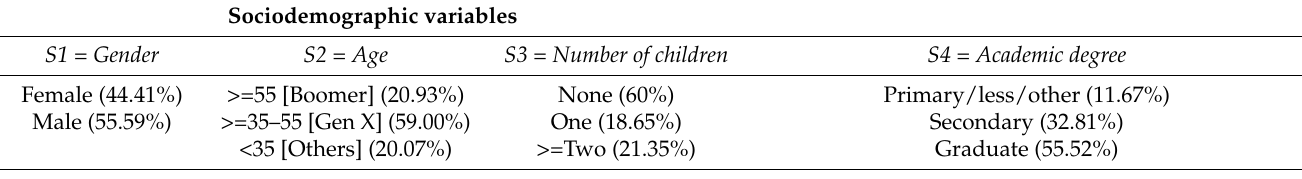
Table 2. Questions and responses on explanatory factors in the